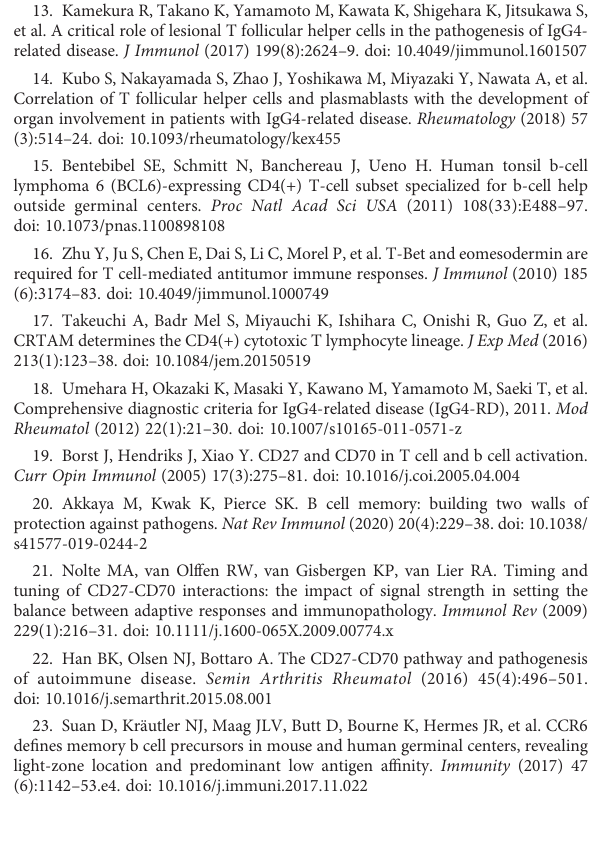
SUPPLEMENTARY TABLE 8 Genes selected by iPathwayGuide analysis to predict regulators of